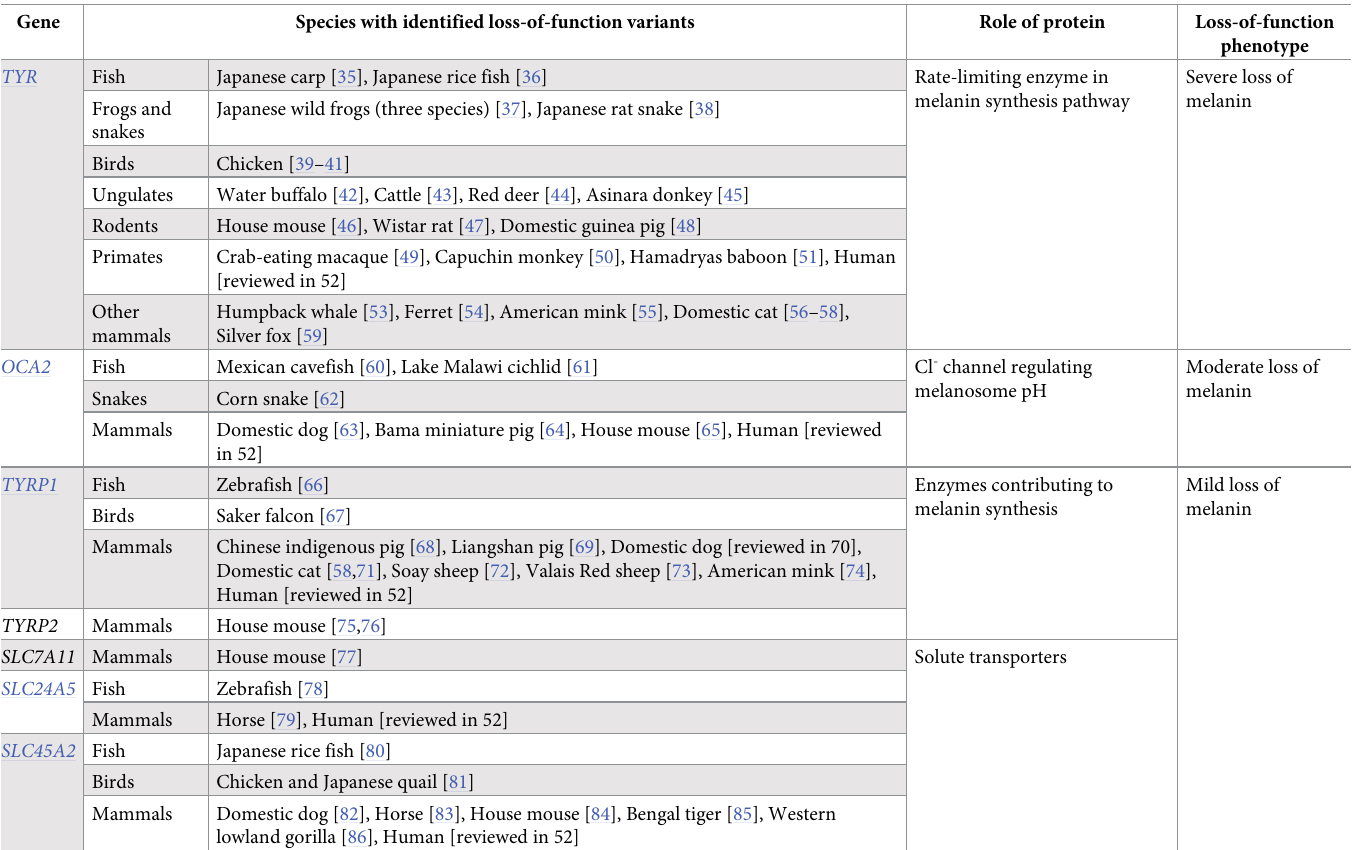
Table 1. Loss-of-function phenotypes of melanogenesis genes across vertebrates. Gene Species with identified loss-of-function variants Role of protein Loss-of-function